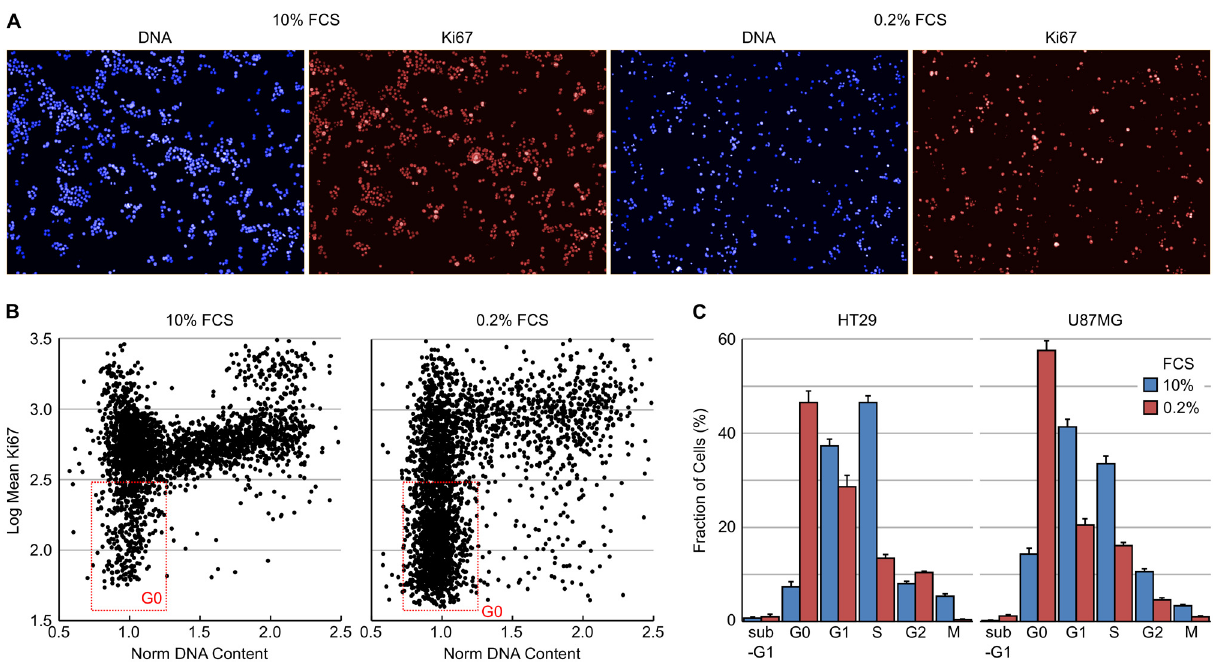
Fig 7. Determination of cellular quiescence using nuclear Ki67 expression levels. HT29 cells growing in 10% FCS or in 0.2% FCS for 72 hours were fixed and stained for Ki67 and pHH3 (S10) expression, total EdU and total DNA content. (A) Example images demonstrating Ki67 staining in HT29 cells. (B) Plots of total DNA versus log mean Ki67 fluorescence intensity demonstrating the identification of the quiescent (Ki67 negative) cell population. (C) Cell cycle distribution of HT29 and U87MG cells grown in 10% or 0.2% FCS determined from multiparametric high-content images. Values are the average of 8 technical replicates ±